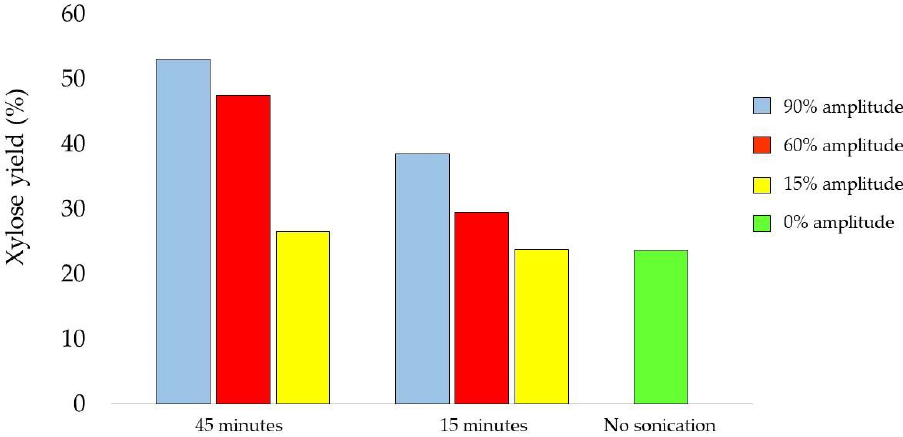
Figure 6. Influence of US amplitude on Xyl yields.